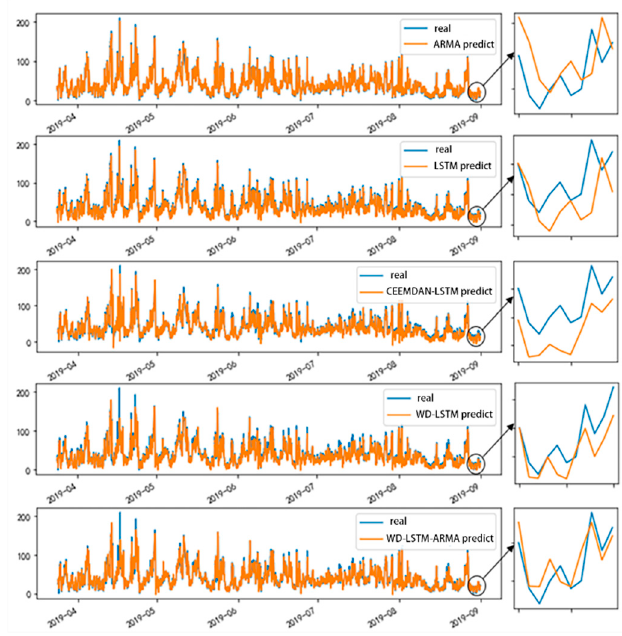
Figure 6. Model prediction results.